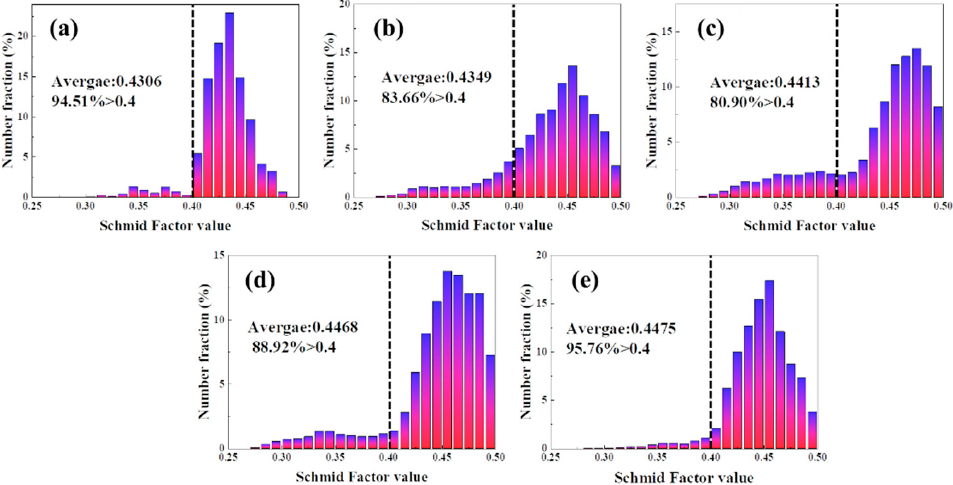
Figure 15. Comparison of texture contents at different temperatures. The activation of slip system is related to the Schmid Factor value of materials [30]. For aluminum alloy with multiple sliding systems, the closer the maximum Schmid factor is to 0.5, the greater the possibility of material sliding system activation, and the lower the yield stress of the material [31]. Figure 16 shows the mean value of Schmid Factor at different deformation temperatures. The average Schmid Factor value of the initial tube is 0.4306 and the proportion of Schmidt factor value greater than 0.4 accounted for 94.51%. When the deformation temperature was 400 ◦ C, the average Schmid Factor value of the tube is 0.4349, and the proportion of Schmidt factor value greater than 0.4 is 83.66%. With the increase in deformation temperature, the average Schmid Factor value of the material increases gradually. When the deformation temperature was 475 ◦ C, the average Schmid Factor value is 0.4475, and the proportion of Schmidt factor value greater than 0.4 is as high as 95.76%.